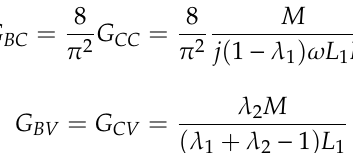
Figure 9. Phase angle of input impedance in CV mode.